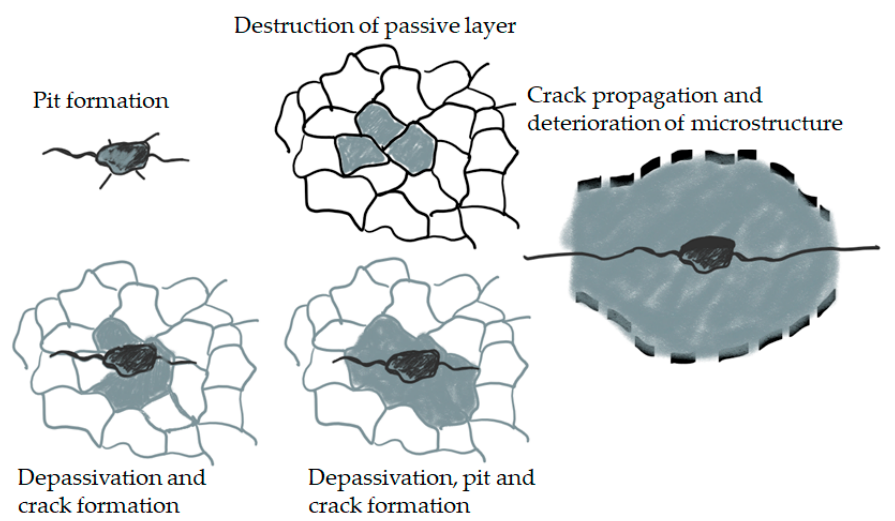
Figure 22. Schematic failure routes during corrosion fatigue. Left: Pitting results in depassivation and crack formation. Middle: Depassivation leads to pitting and crack formation. Right: Crack formation and degradation of the microstructure within the crack flank region.